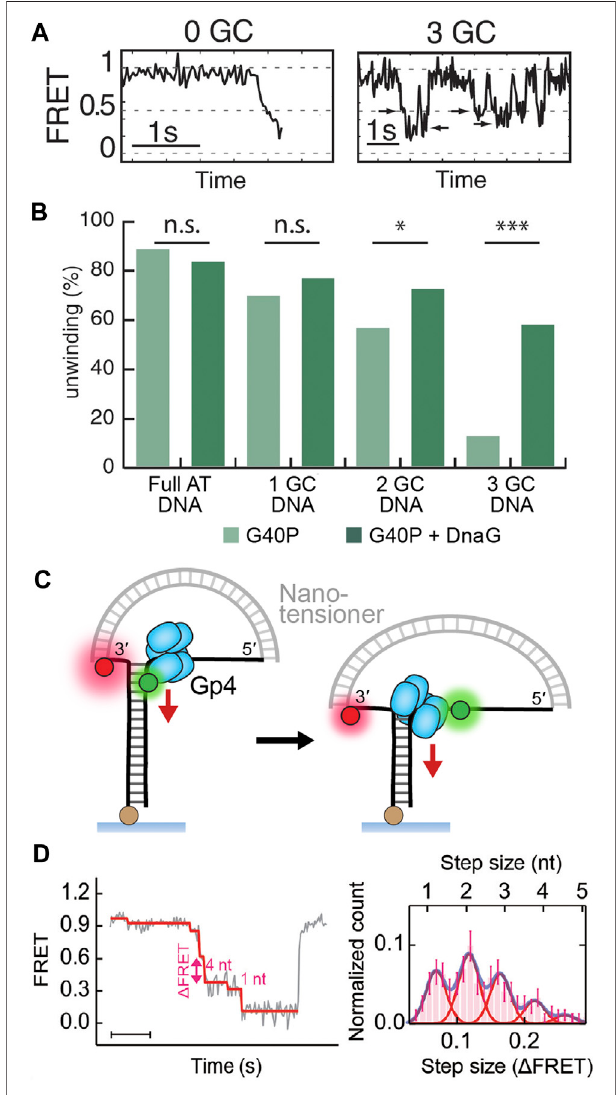
FIGURE 5 | Detection of replicative helicase stepping using single-molecule FRET. (A) Typical FRET unwinding traces for G40P, the DnaB-like helicase(Schlierf et al., 2019).On templates containingno GCbase pairs, G40P unwinding exhibits a rapid decrease in FRET. On templates containing 3 GC base pairs, G40P frequently stalls (see arrows), slips backwards and then re-attempts unwinding. (B) The percentage of FRET templatesunwoundbyG40PdecreaseswithincreasingGCDNAcontent,but ahigher percentage canbe recovered withtheinclusionoftheDnaG primase. (C) A nanotensioner applied to the single-molecule FRET unwinding assay stabilizes the overhangs of the unwound DNA strands and thus improves the resolution in FRET signal to < 1 bp (Lin et al., 2017). (D) Typical FRET unwinding traces for the gp4 helicase, where a nanotensioner is incorporated into the DNA template. (Ma et al., 2020). A histogram of gp4 step sizes (right) shows the helicase can sample a hierarchy of steps with 2 nt/step being the most common